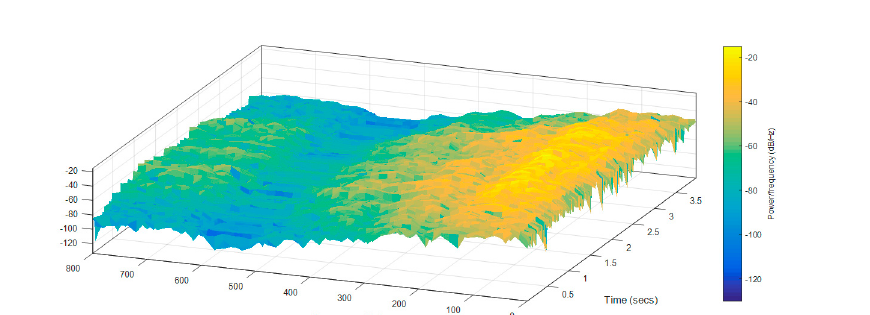
Figure 12. Frequency spectra of the accelerations measured over the longitudinal axis at the head of the APR-1 prototype (without suspension).